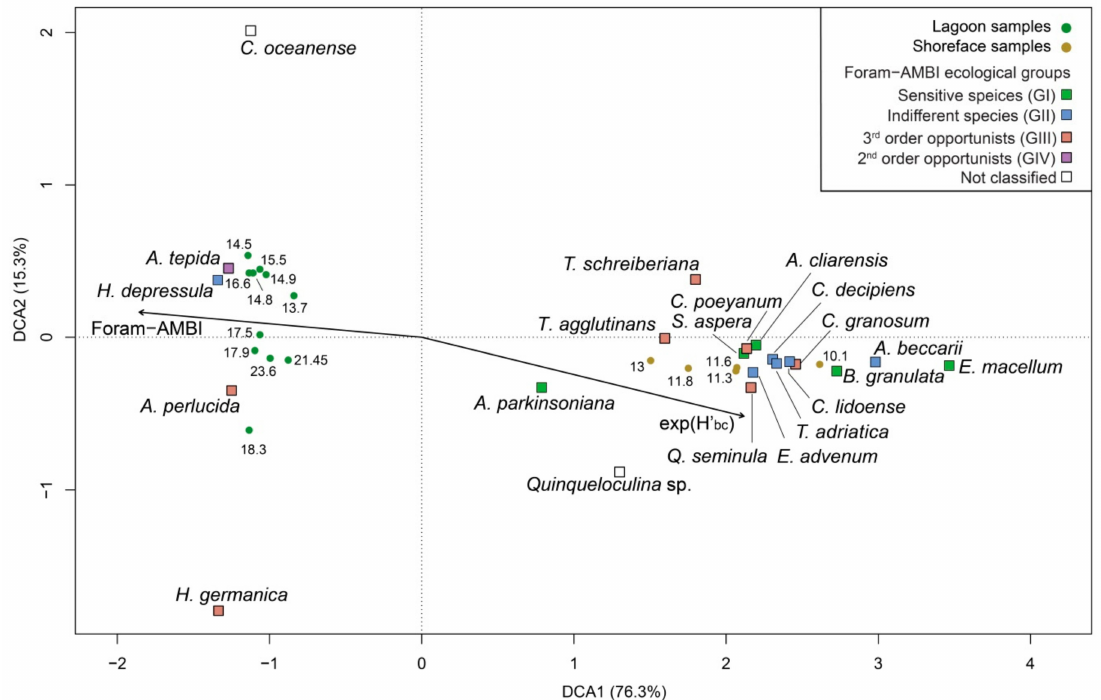
Figure 5. Detrended correspondence analysis (DCA) applied on the benthic foraminifer dataset of core 240 S6, showing samples and taxa. Samples are colored according to the facies association; taxa are colored in accordance with the Foram − AMBI ecological group. Total variance explained by each axis is reported. Exp(H’ bc ) and Foram − AMBI indices are plotted as additional